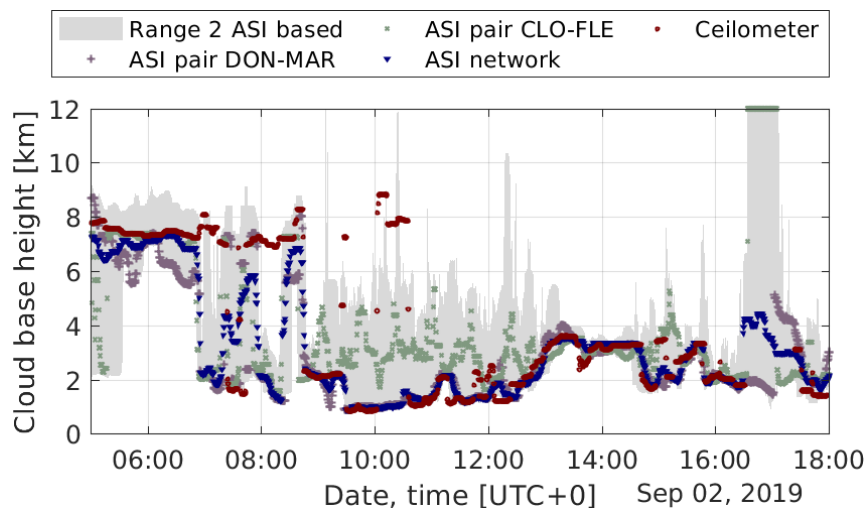
Figure 6. Time series of cloud base height for an exemplary day (2 September 2019) measured by 42 ASI pairs (gray filled), by two exemplary ASI pairs, DON-MAR and CLO-FLE, with respective camera distances 0 . 8 and 4 . 2km, by the ASI network with refinements and by a ceilometer in the urban area of Oldenburg.